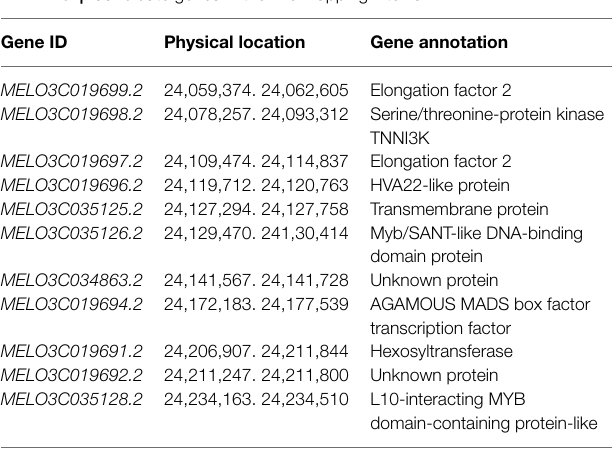
TABLE 3 | Candidate genes in the fine mapping